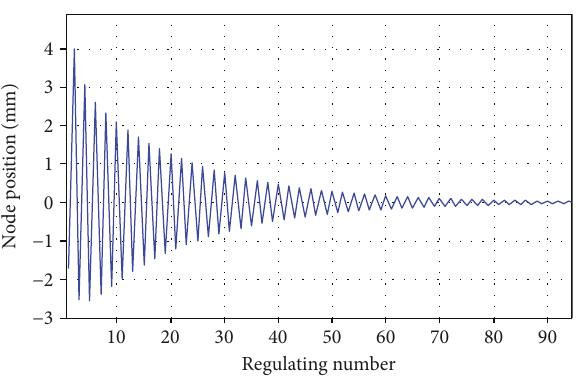
Figure 4: LQR adjustment curve of Node 1.